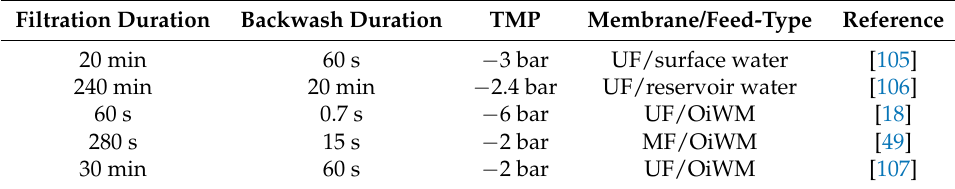
Table 2. Backwashing configurations for ceramic